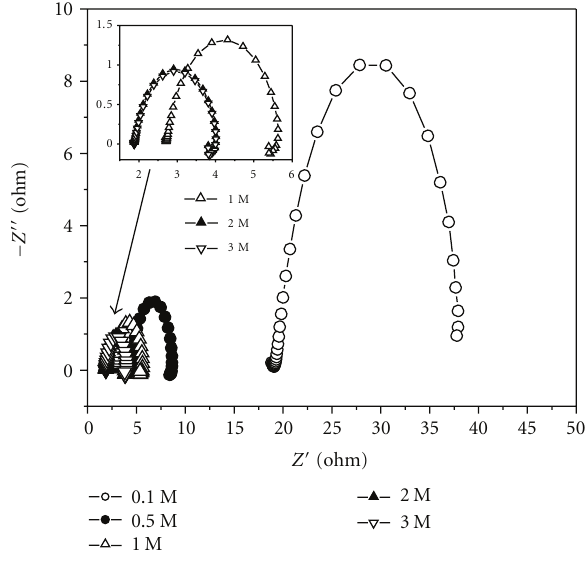
Figure 16: Impedance spectra (Nyquist plot) for methanol oxida- tion on Pt-Pd/C catalyst in 1.0M methanol with various concentra- tions of NaOH at − 160 mV and 25 ◦